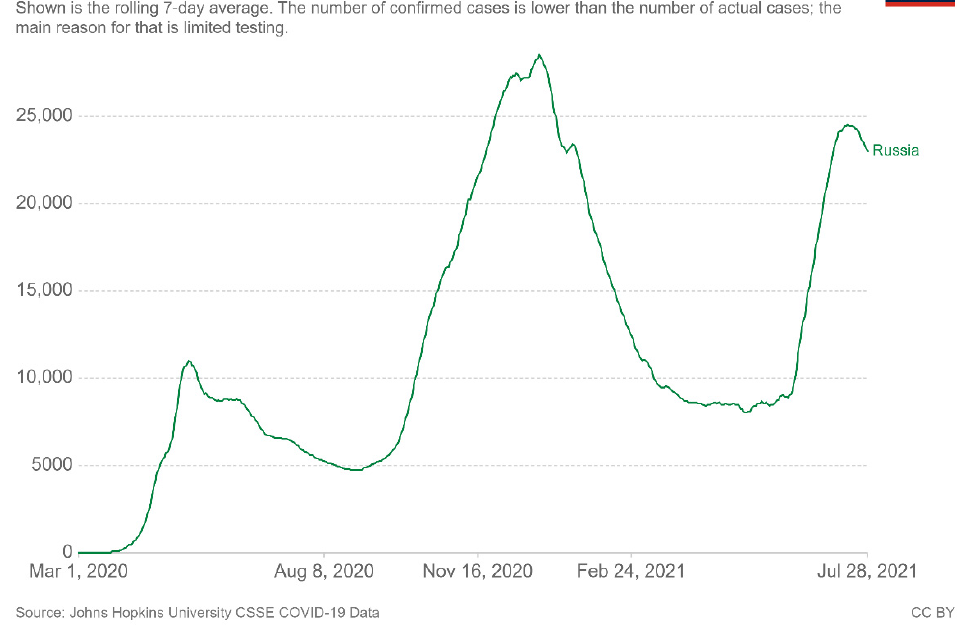
Figure 1. Daily number of confirmed COVID-19 cases in Russia (source: Our World in Data [16]). Official COVID-19 mortality figures, as of 28 July 2021, indicate a death toll of almost 157,000 [12]—i.e., 0.1% of the population—suggesting lower mortality rates compared to Western nations (0.185% and 0.191% for the USA and the UK, respectively [17]). However, that number only accounts for deaths for which COVID-19 has been confirmed to be the primary cause of death by autopsy [18]. This way of tallying goes against the recommen- dations of the WHO to count all deaths “resulting from a clinically compatible illness, in a probable or confirmed COVID-19 case, unless there is a clear alternative cause of death that cannot be related to COVID disease (e.g., trauma)” [19]. Data published by Russia’s